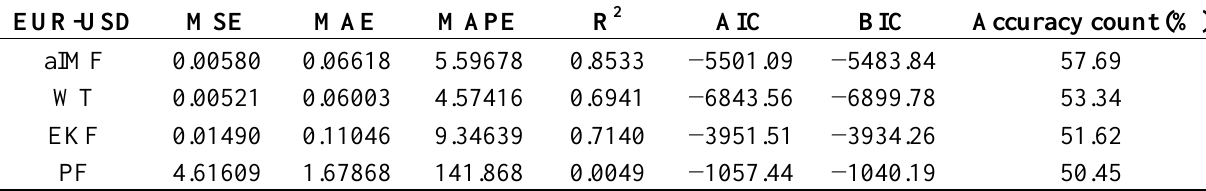
Table 6. Performance measurements of original datasets using noise distribution at 100% with 10 Hz and 20% amplitude of the original